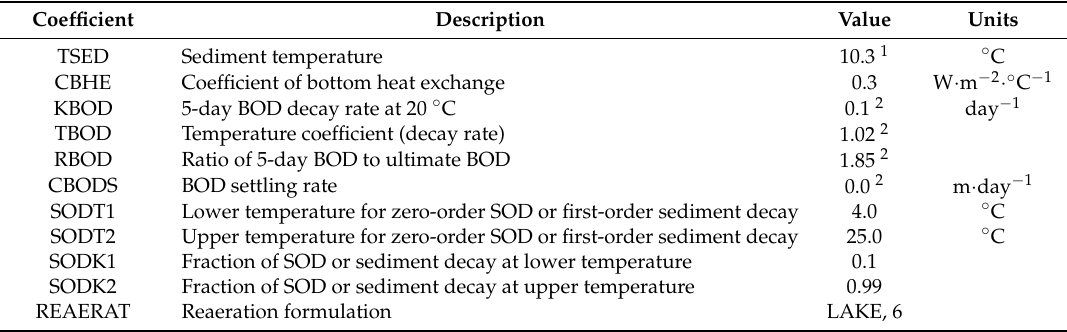
Table 1. W2 Default kinetic coefficients used in this study for the sediment oxygen demand (SOD) and biochemical oxygen demand (BOD)